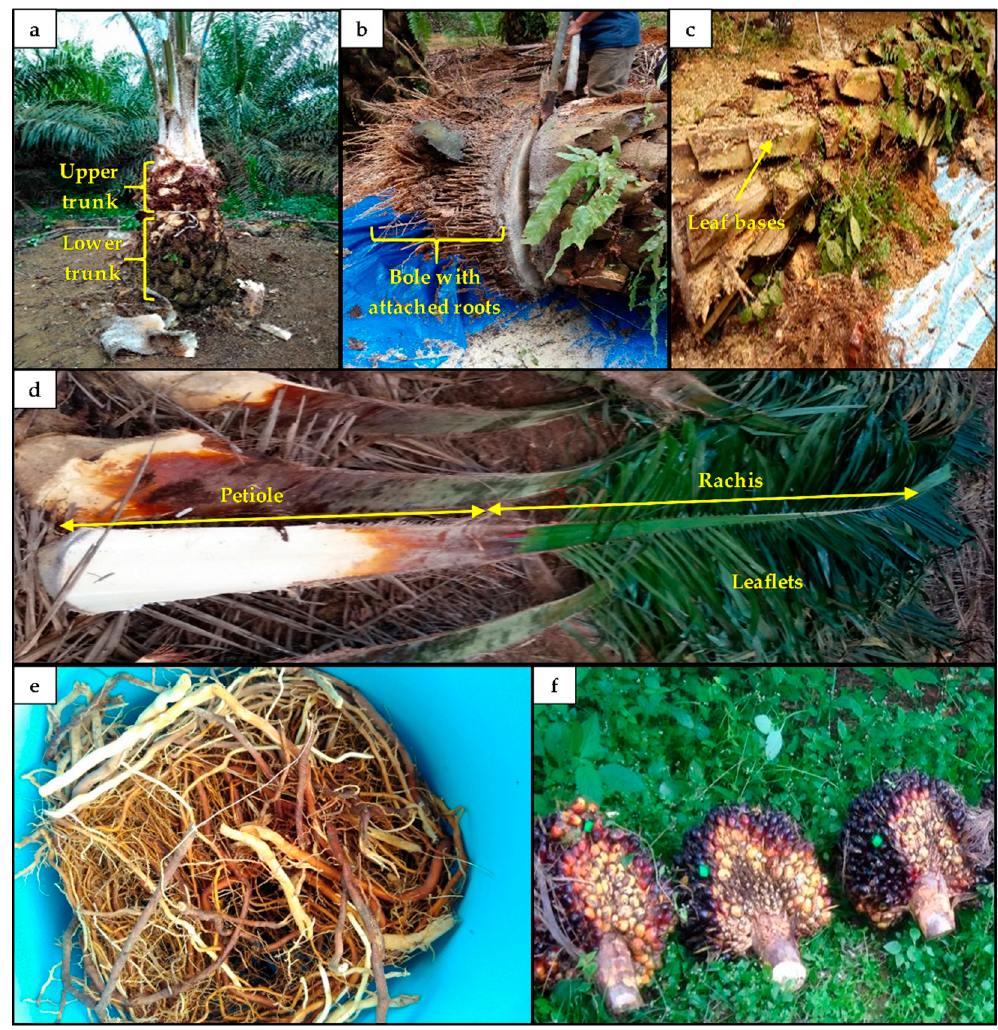
Figure 1. Destructive sampling of the tenera oil palm. ( a ) A 5-year-old palm, after almost all leaves were removed before it was felled. Upper and lower trunk were identified and marked. ( b ) Cutting the bole of an uprooted palm using chainsaw and chisel. ( c ) Oil-palm trunk with leaf bases attached to it. ( d ) Oil-palm leaves with petiole, rachis, and pinnae identified. ( e ) Cleaned oil palm roots. ( f ) Harvested bunches. Left—ripe bunch; middle and right—unripe